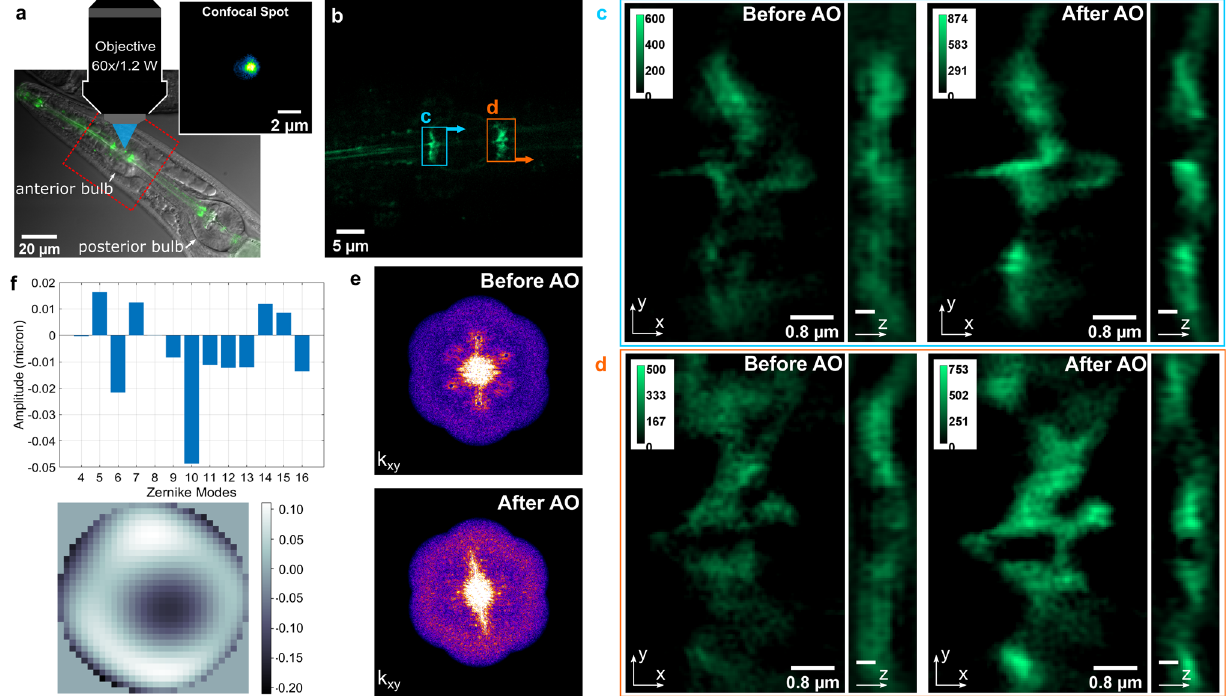
Fig. 7 Live C. elegans expressing the adherens junctions marker ajm-1 ::GFP. a An image overlay of a fl uorescence image and a DIC phase image to illustrate the location of the AJs inside C. elegans and the image of the confocal spot (inset). b Wide fi eld image of AJs in the anterior bulb of the pharynx. c 3D-SIM images of AJs in area a before and after AO correction. d 3D-SIM images of AJs in area b before and after AO correction. e Effective OTF of 3D- SIM images before (upper) and after (bottom) sample aberration correction. f The amplitudes of Zernike modes and the applied wavefront.